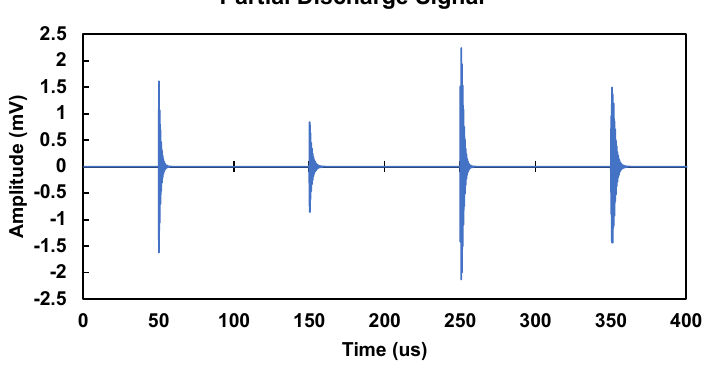
Figure 9. Simulated partial discharge